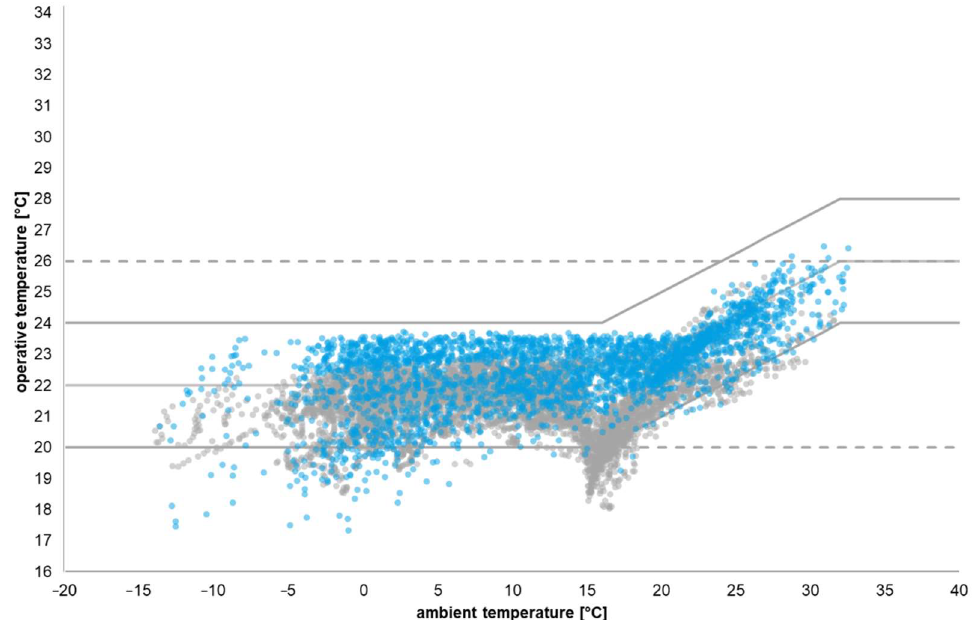
Figure 5. Annual operative temperature over the outdoor temperature without active conditioning during occupancy (blue) and all year (grey) (own representation).